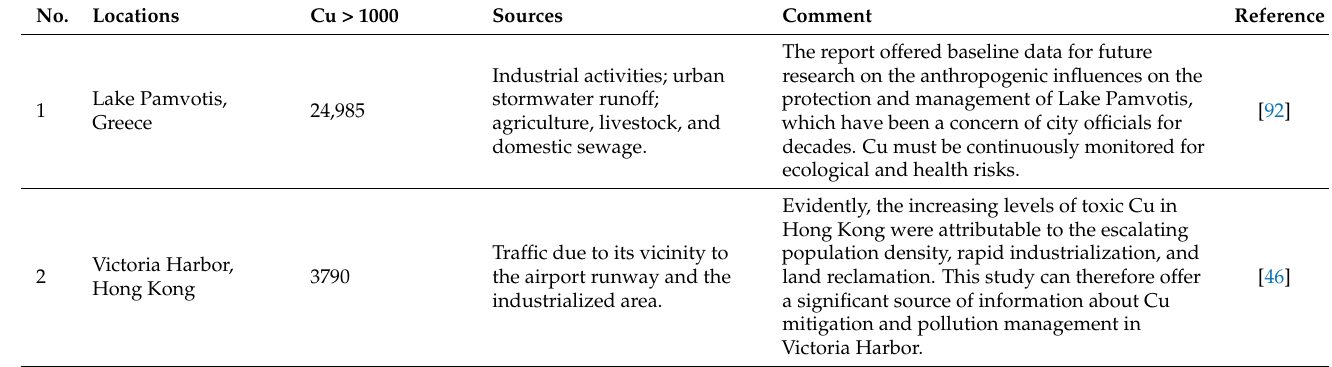
Table 4. Comments on the 11 papers with Cu concentrations over 500 mg/kg dry weight from 125 papers in the